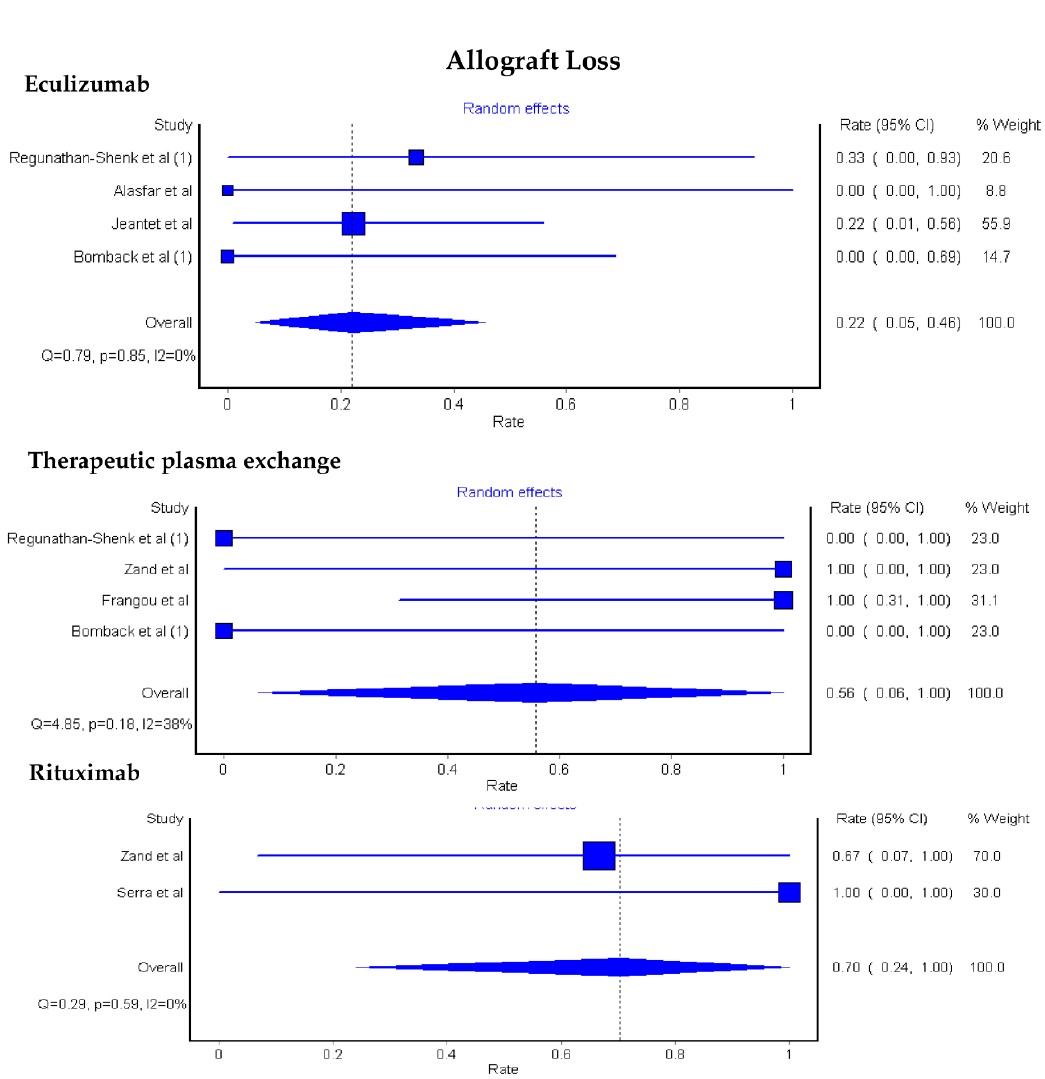
Figure 3. Pooled estimated rates of allograft loss among KTx patients with